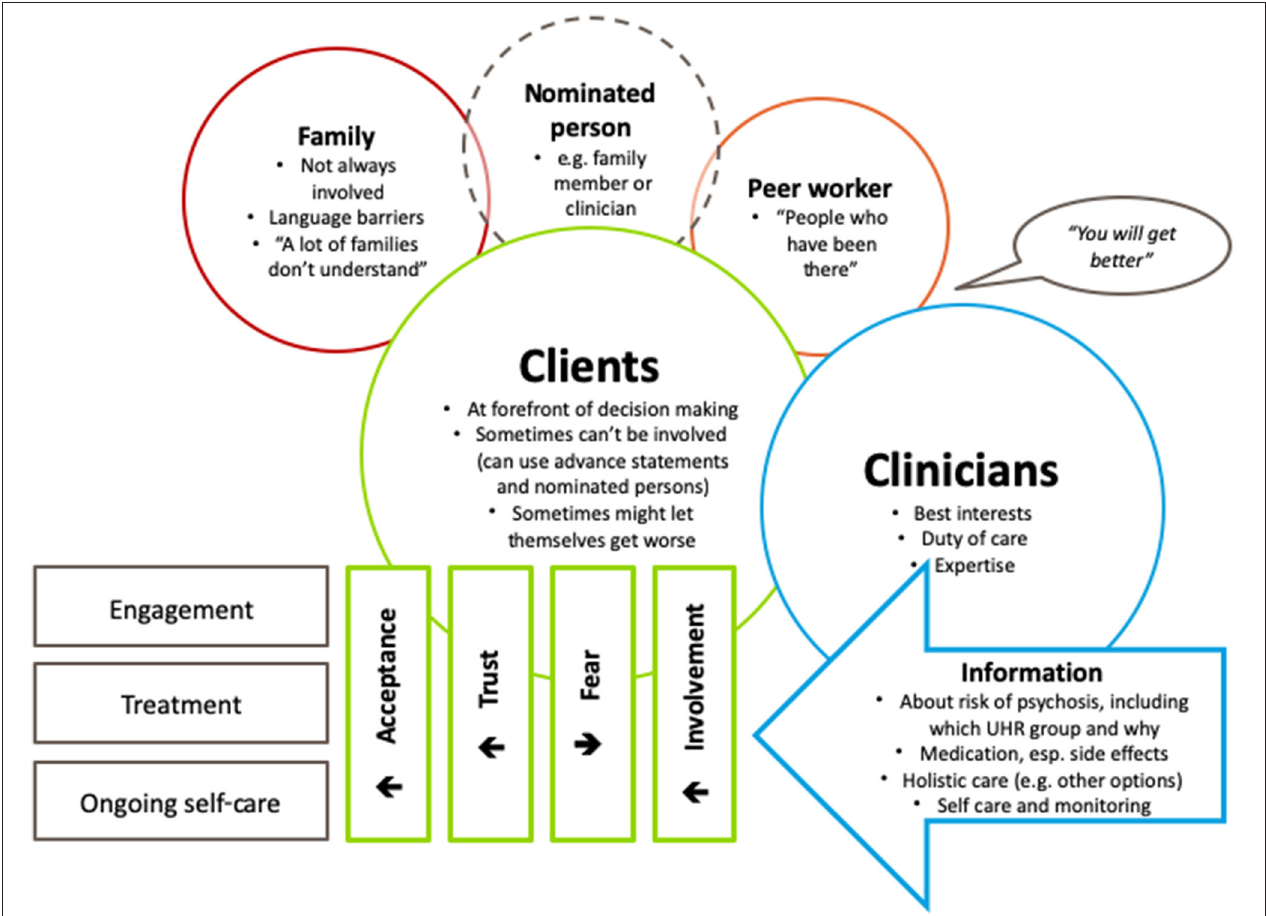
FIGURE 2 | Thematic map of client reported experiences and beliefs about treatment decision making for young people who meet the “Ultra High Risk” (UHR)